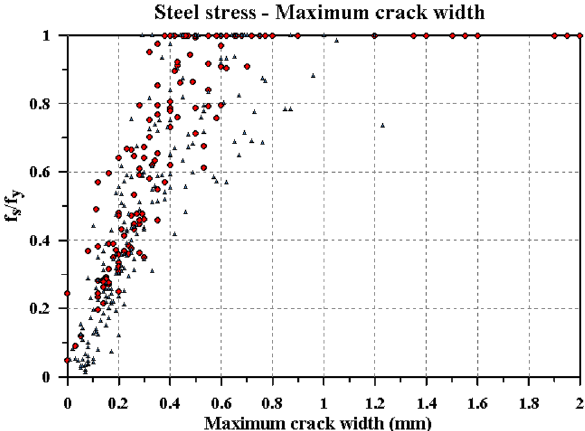
Fig. 23 Relationship between the maximum flexural crack width and maximum tensile stress of main bars (Circle points are the specimens in this work; triangle points are the specimens in the references (Chiu et al. 2014,